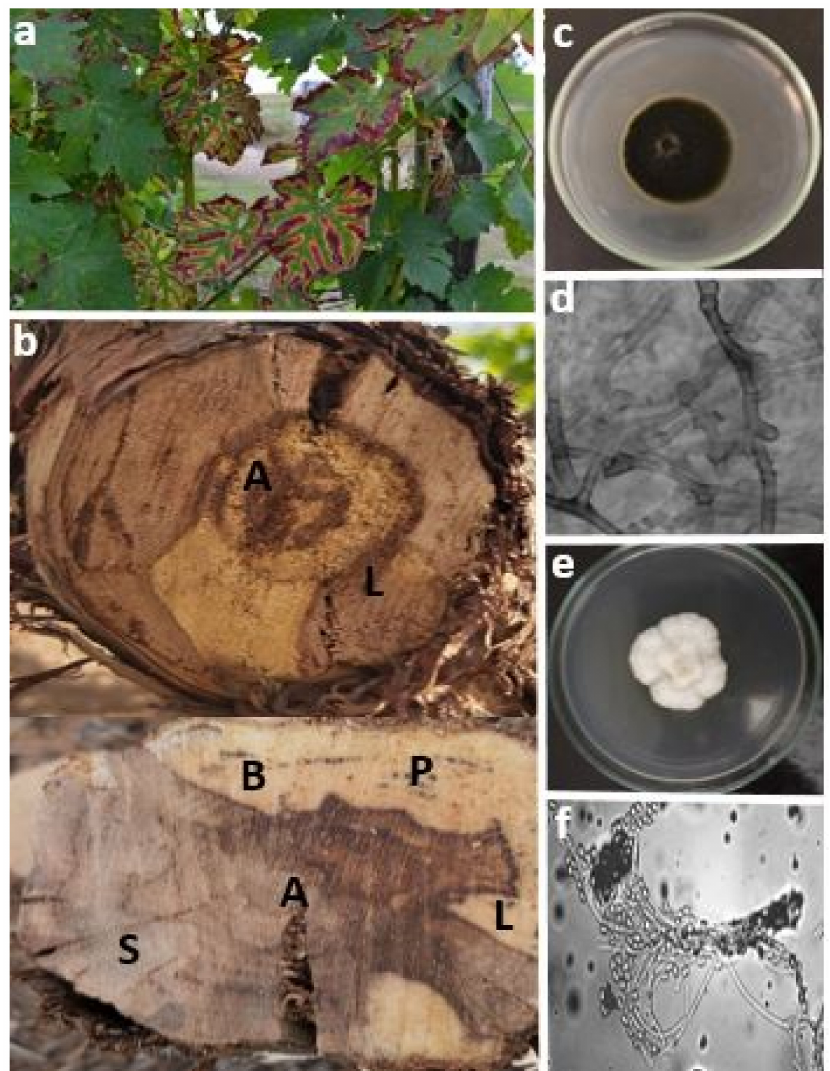
Figure 4. ( a ) Leaf symptoms of esca on grapevine; ( b ) necrosis observed in affected vines ( A. white rot; L. interaction zone (border) located between white rot and healthy wood; P. black spots; S . sectorial necrosis; B. healthy wood); ( c ) morphological characteristics of Phaeomoniella chlamydospora ; ( d ) globu- lar chlamydospores formed within the mycelium; ( e ) morphological characteristic of Phaeoacremonium minimum ; ( f ) conidiophore and hyaline conidia, oblong-ellipsoid to an allantoid characteristic of P. minimum